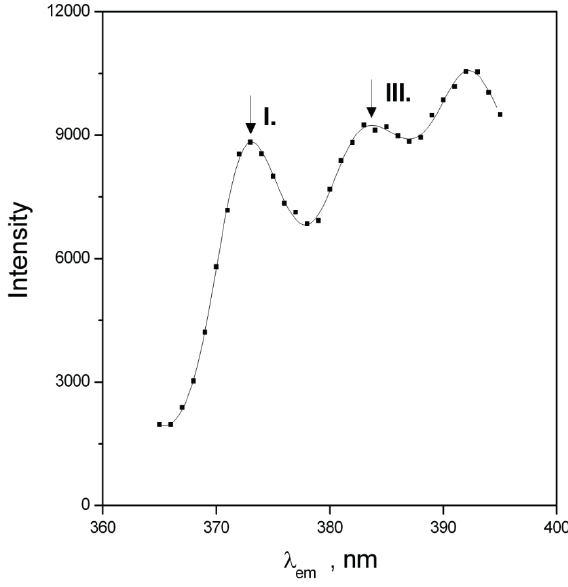
Figure 1: Pyrene emission spectrum at the excitation wavelength λ = 340 nm, the CTAB concentration 15 × CMC and the quencher exc concentration 8 × 10 -4 mol L -1